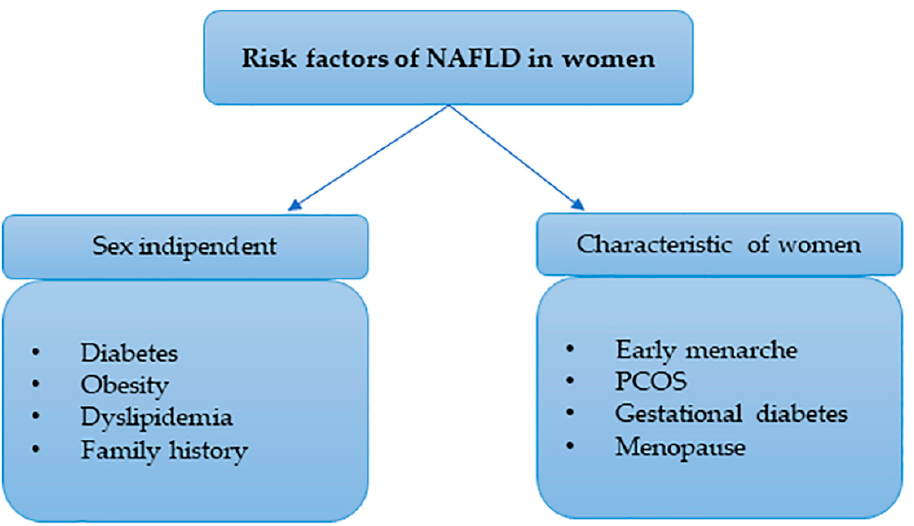
Figure 2. Risk factors in women. Risk factors in women may be gender-independent, such as diabetes, obesity, dyslipidemia and a family history of NAFLD, or they may be gender-dependent, particularly in relation to personal history, early menarche, PCOS, gestational diabetes and menopause.